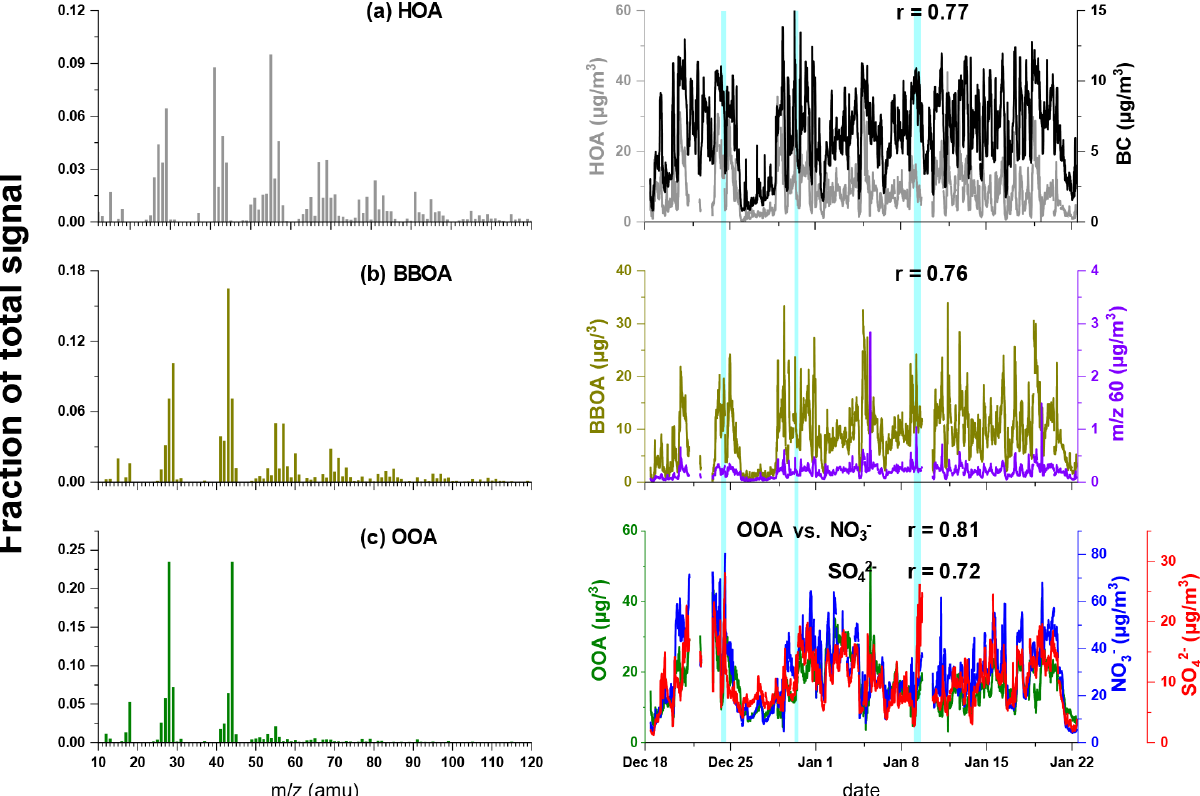
Figure 5. Mass spectrum of (a) HOA, (b) BBOA, and (c) OOA resolved by PMF. The time series of each OA source and corresponding tracers are depicted in the right column. The light-blue-shaded areas represent the intervals of foggy